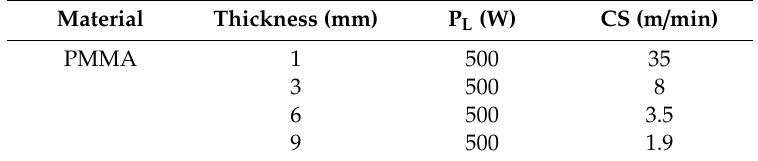
Table 2. Cutting parameter levels for PMMA in the vaporization cutting mechanism [22].